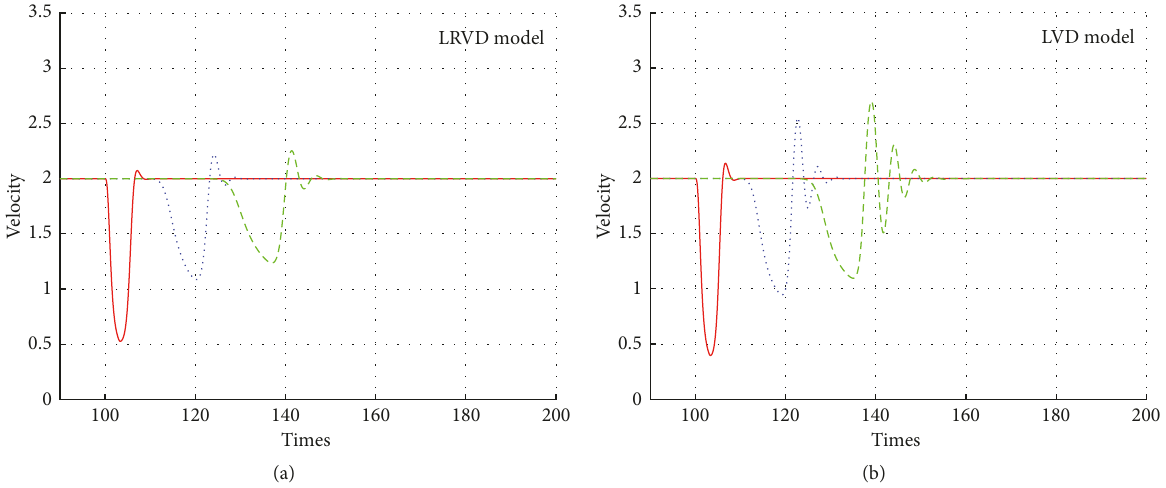
Figure 5: (Color online) speed-time profile of the LRVD model (a) and LVD model (b) after the first car stops from the 100 s to 103s. (a) 𝜆 = 𝜆 = 𝜆 = 0.2 (b) 𝜆 = 0 , 𝜆 = 𝜆 = 0.2 . As time passes by, the red line represents the speed fluctuation of the 3rd car behind the first 1 2 3 3 1 2 car, the blue line represents the speed fluctuation of the 25th car, and the green line represents the speed fluctuation of the 50th